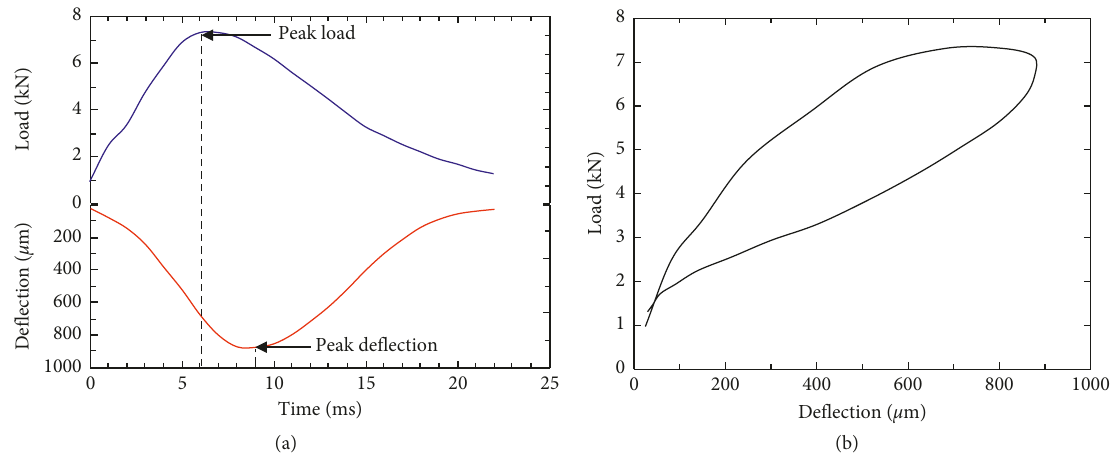
Figure 4: PFWD results for L4. (a) Load and deflection time-history curve. (b) Load-deflection curve.